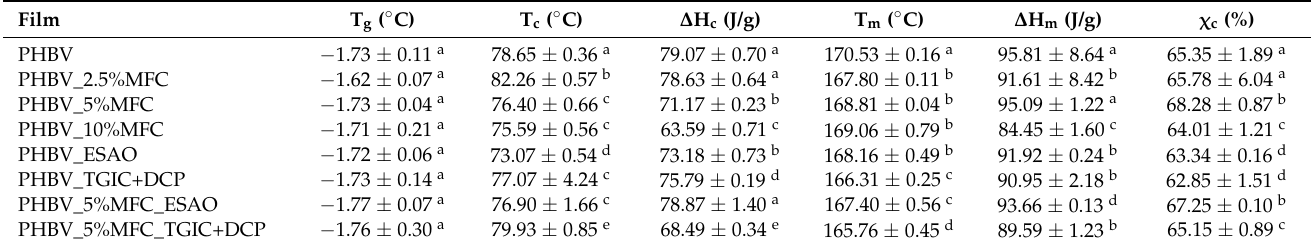
Table 3. Thermal properties obtained by differential scanning calorimetry (DSC) of the films of poly(3-hydroxybutyrate- co -3-hydroxyvalerate) (PHBV) with microfibrillated cellulose (MFC) and compatibilized with epoxy-based styrene-acrylic oligomer (ESAO) and with triglycidyl isocyanurate (TGIC) and dicumyl peroxide